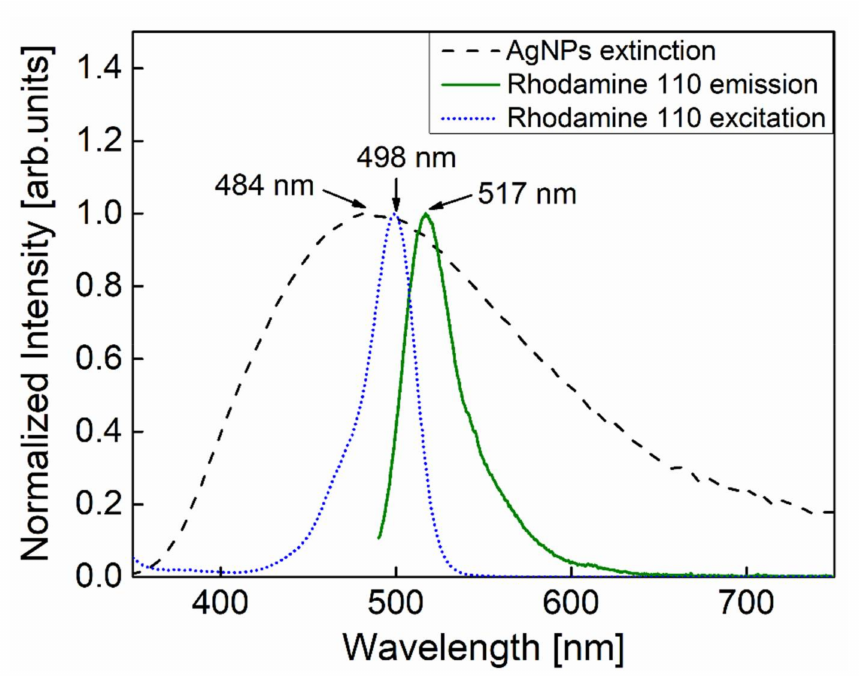
Figure 2. A rhodamine 110 excitation spectrum (blue dotted curve) is taken from the dye manu- facturer data. The green solid curve and black dashed curve represent the measured spectra of fluorescence emitting from rhodamine 110 dispersed within a SiO 2 layer, and the LSPR-induced extinction due to the AgNPs embedded within the layer, respectively.